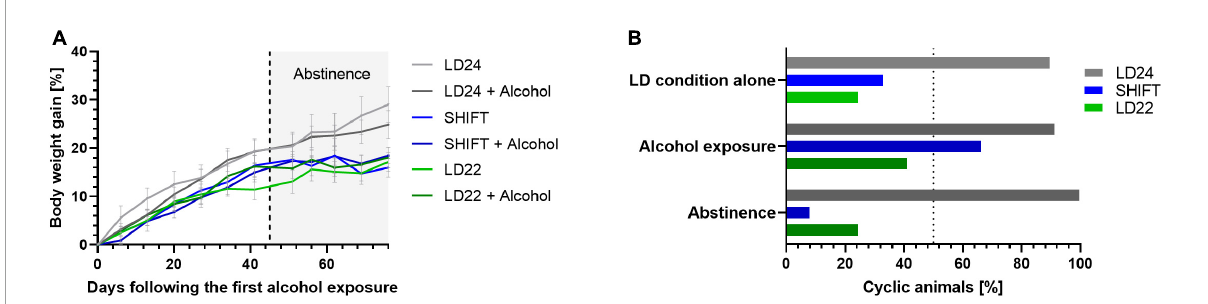
FIGURE6 Body weight gain and estrous cyclicity under altered light-dark (LD) schedules, alcohol exposure, and abstinence. (A) Change in body weight gain (%) over time. (B) Comparison of estrous cyclicity between LD alone and in combination with alcohol access and abstinence as indicated by the percentage of animals showing a rhythmic estrous cycle (%). ± SEM; n = 4–12/LD condition.